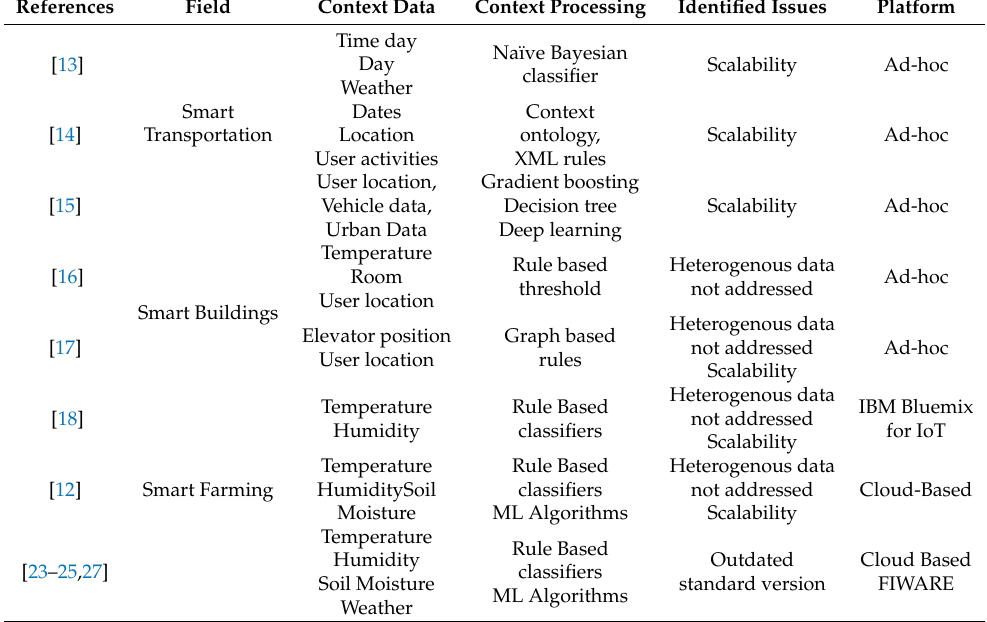
Table 1. Summary of context-aware applications in smart